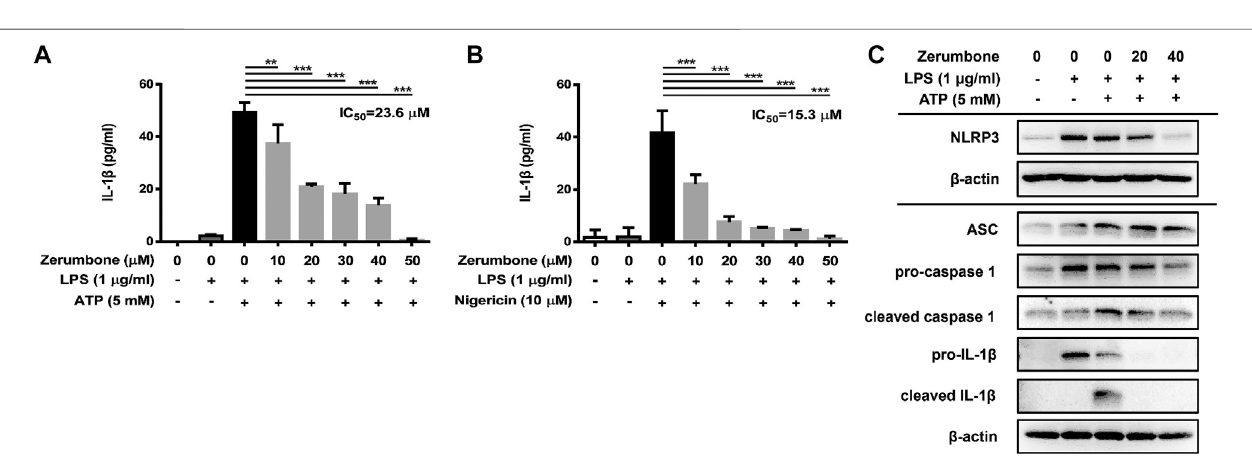
FIGURE4 | The effects ofzerumbone on the production of IL-1 β and the activity of NLRP3 in fl ammasome in LPS/ATP- and LPS/nigericin-activated J774A.1 cells. Cells were pre-treated with various doses of zerumbone for 1 h and then treated with LPS (1 μ g/ml) for 5 h following treatment of ATP (5 mM) or nigericin (10 μΜ ) for 30 min. (A, B) Cellculture supernatants werecollectedand thelevels ofIL-1 β weredetermined byELISA.Datawererepresentedasmeans ± SD.Statisticalsigni fi cance between the zerumbone-treated groups vs. the LPS/ATP or LPS/nigericin groups is represented as follows: * p < 0.05, ** p < 0.01 and *** p < 0.001. (C) The expression levels of in fl ammasome-associated proteins were analyzed by Western blot. β -actin was regarded as a loading control. The representative Western blot results were obtained in three separate experiments.